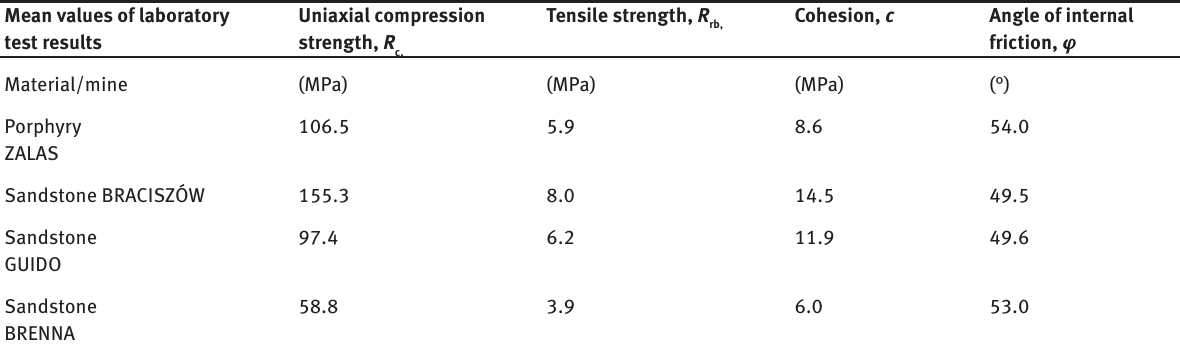
Table 1: Results of laboratory tests of the material samples [24].